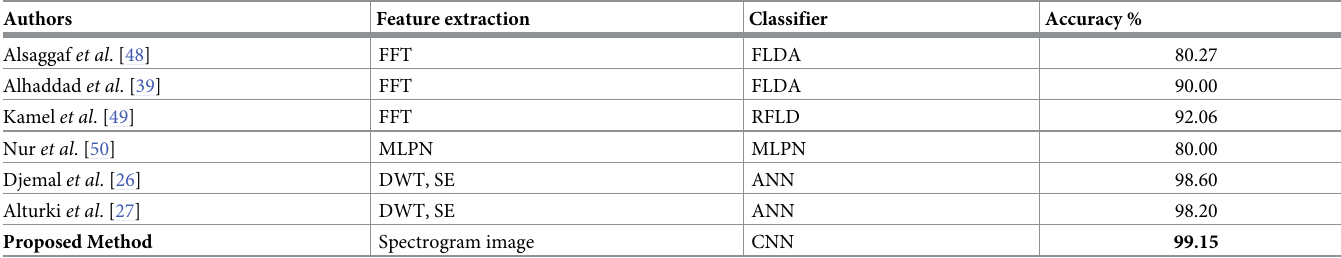
Table 3. Comparison with proposed and existing methods using same dataset.